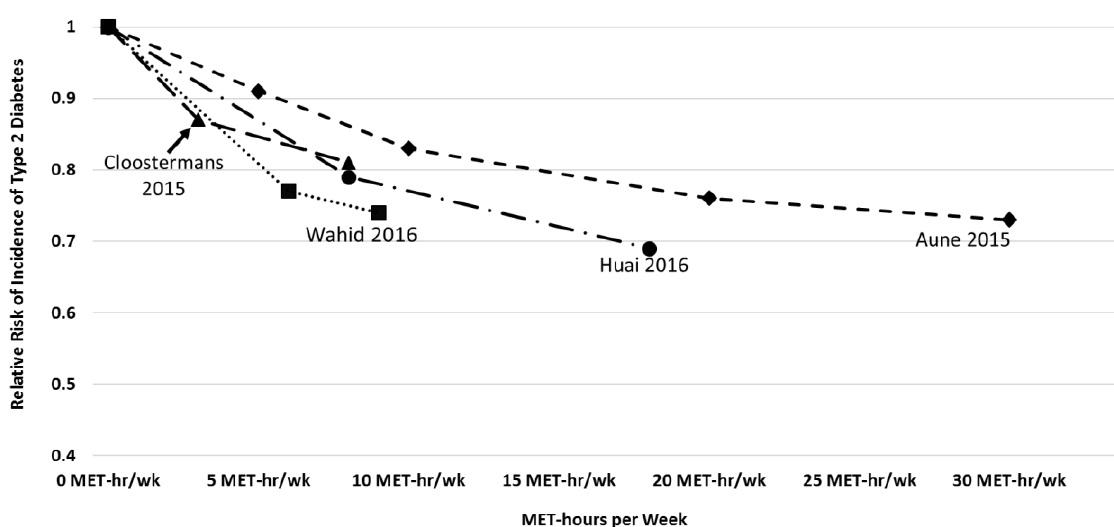
Figure F5-5. Dose-response Curves for Moderate-to-Vigorous Physical Activity and Relative Risk of Type 2